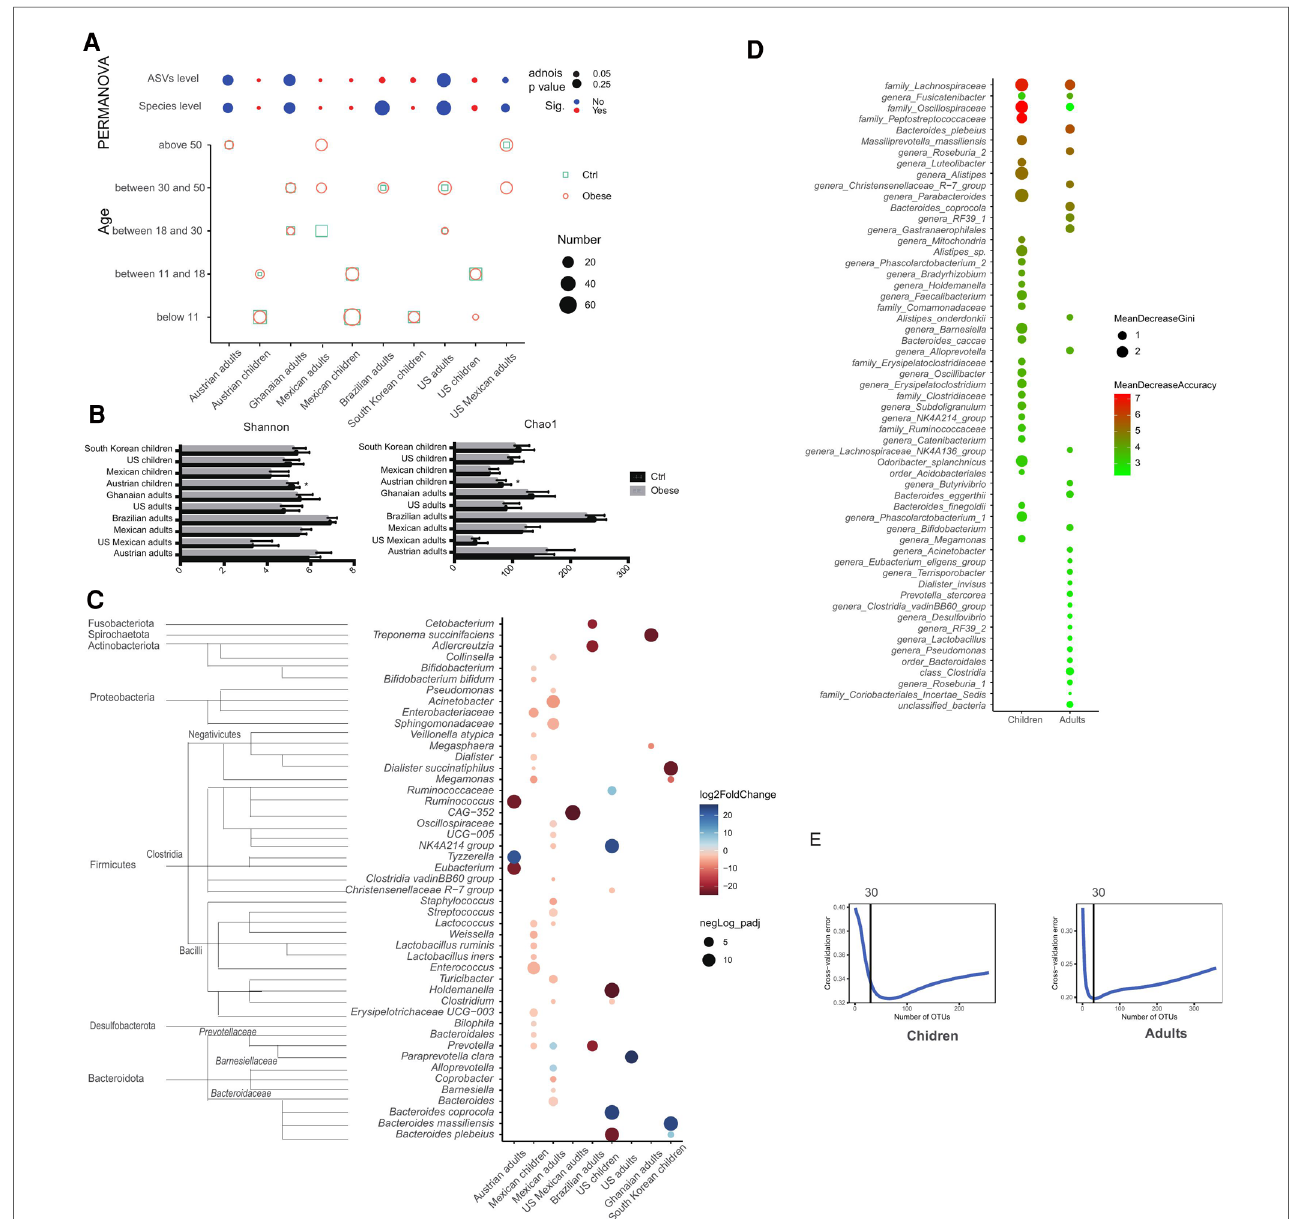
FIGURE 1 Comparison of gut microbiota between obese and control groups in different cohorts. ( A ) Distance of gut microbiota between obese and control individuals analyzed using PERMANOVA and age distributions in different cohorts; ( B ) Alpha diversity of gut microbiota in different cohort; ( C ) Bacteria with signi fi cant difference in abundance between control and obese individuals in different cohorts (Blue means bacteria had higher abundance in control group than obese group, vice versa); ( D ) Top 30 taxa used to predict obesity using the random forest model; ( E ) Cross validation errors of both children cohorts and adults cohorts in random forest